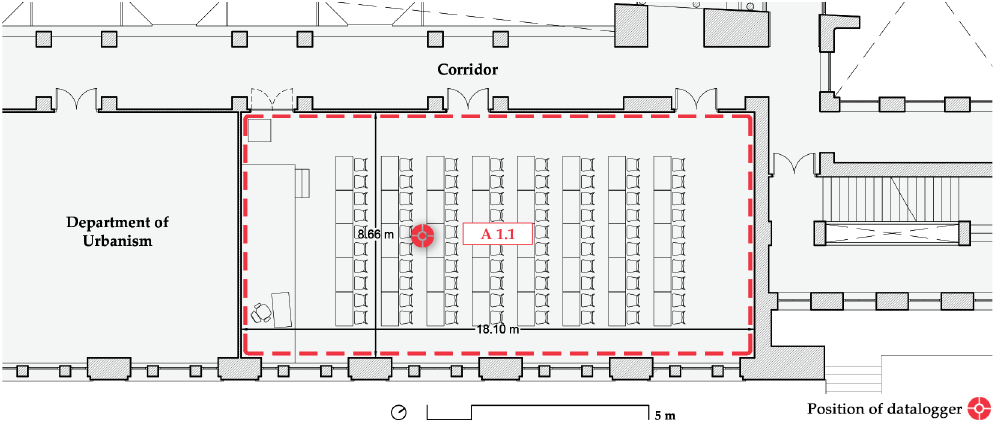
Figure 5. Floorplan of room A 1.1 on the first floor. Source: authors.